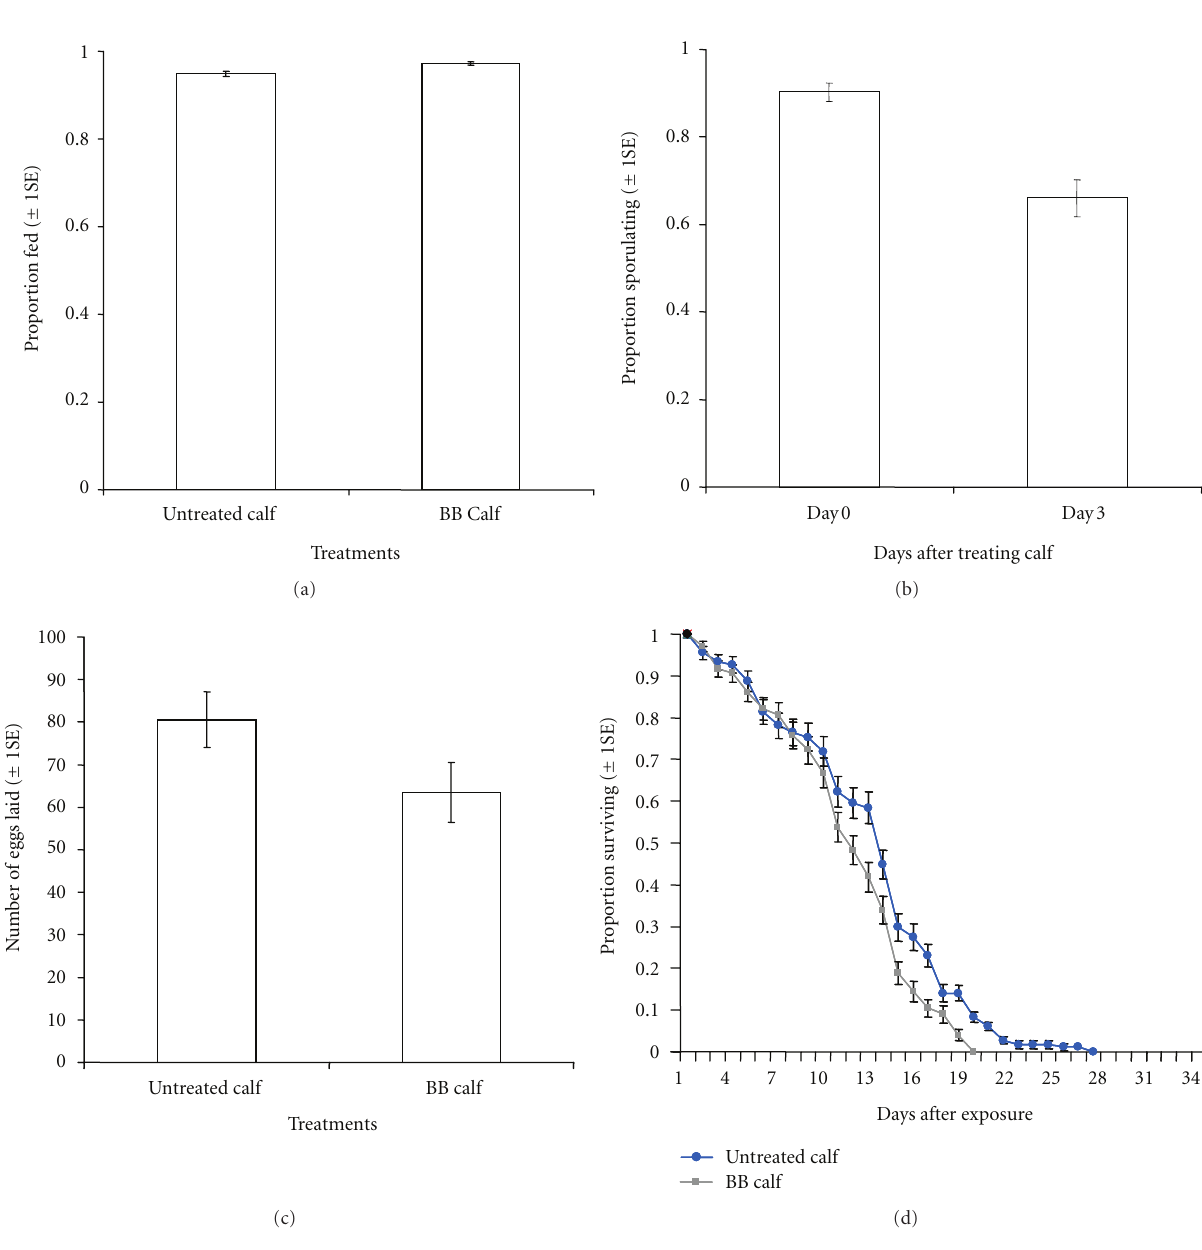
Figure 3: E ff ects of B. bassiana against semifield reared exophilic An. arabiensis populations: (a) Estimated proportion ( ± 1s . e) of fed after exposure to fungus-treated and untreated calf, BB calf indicates a calf sprayed with conidia suspension of Beauvaria bassiana. (b) Estimated proportion ( ± 1s . e) of infected mosquitoes after exposure to fungus treated calf on 0 d and 3d. (c) Estimates ( ± 1s . e) of the mean number of eggs laid by mosquitoes after exposure to fungus-treated and untreated calf. (d) Survival of mosquitoes after exposure to fungus-treated and untreated calf, the lines represent the survival function as estimated from fitting Cox proportional hazard model (controlling for random variation between individual